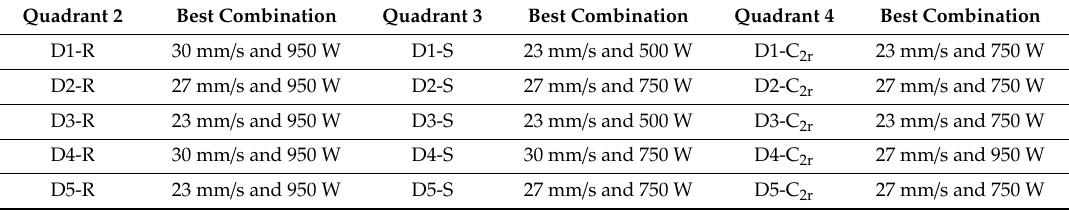
Table 9. Best factor combinations for the defects in the rest of the